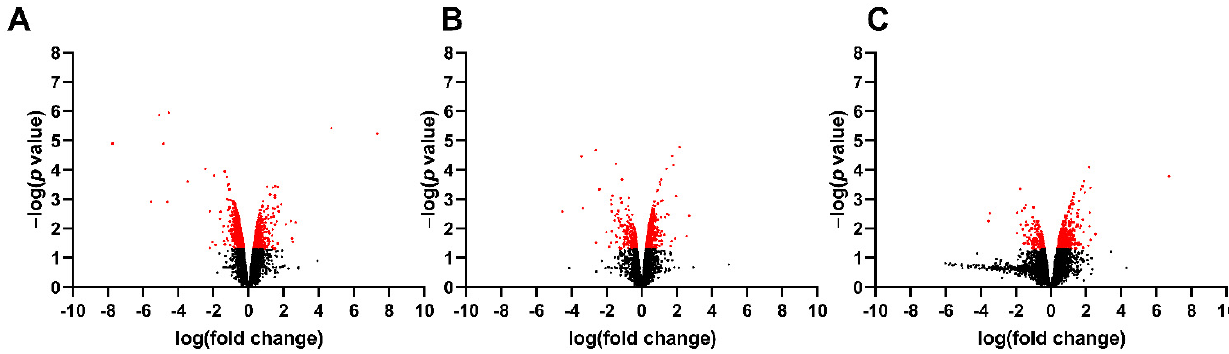
Figure 3. Volcano plot illustrating RNA-seq data of fetal spinal cords isolated from MMC and control at ( A ) E15, ( B ) E17, and ( C ) E20. Red identifies genes that were greater than 1.5-fold change and p < 0.05.